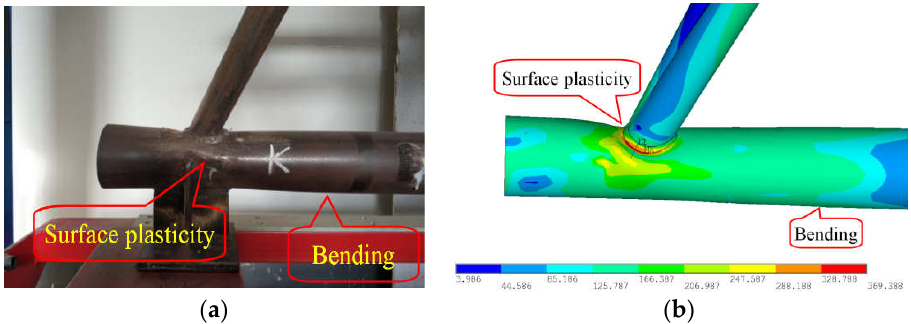
Figure 18. Comparison of experimental and FEA failure mode for specimen T-HW at the joint ‘k’. ( a ) Experimental; ( b ) FEA analysis.